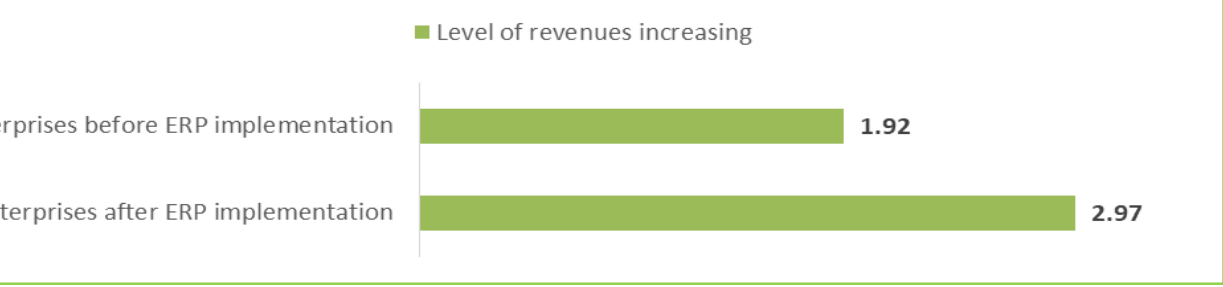
Figure 6. Increases in revenues in construction enterprises before and after ERP